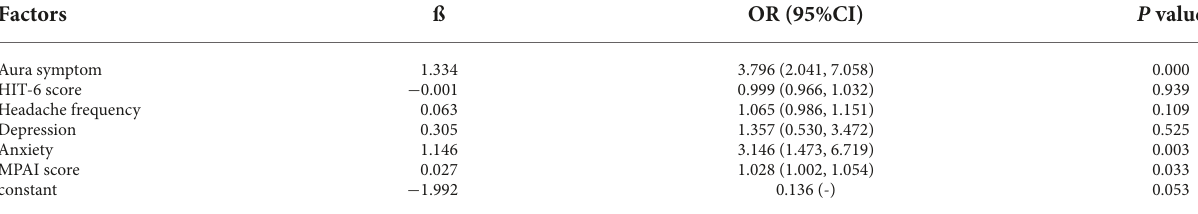
TABLE 6 Multivariate logistic regression analysis of factors associated with sleep quality in female migraine patients.